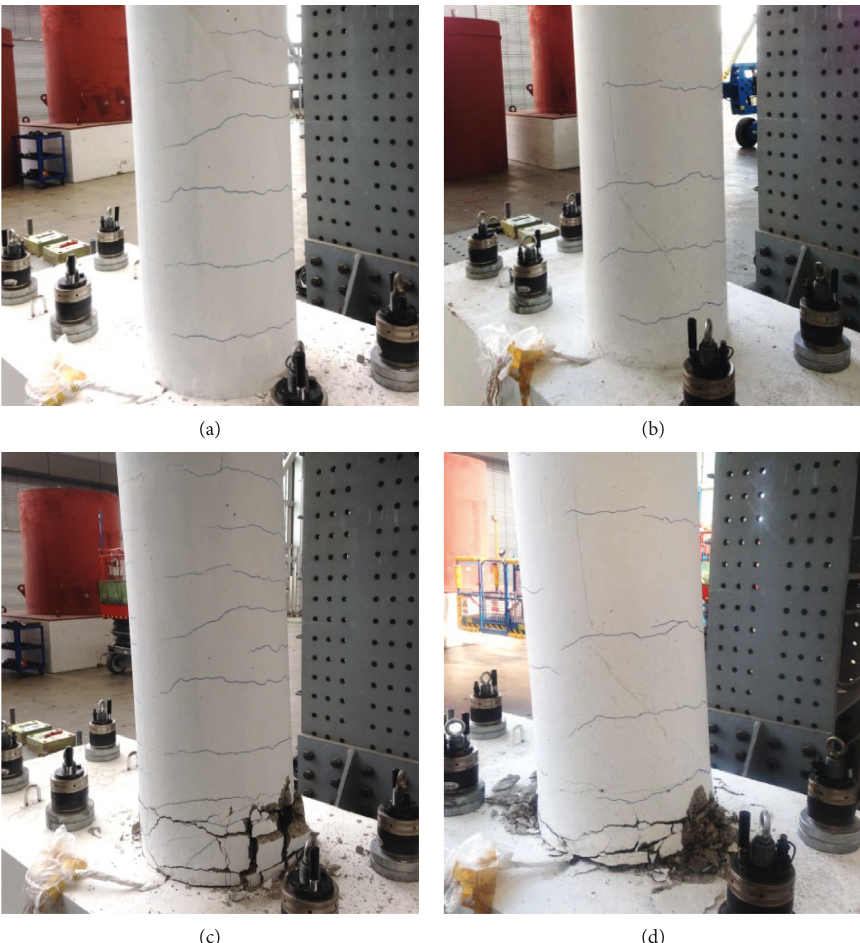
Figure 10: Connection damages: (a) T-SD400 at 0.67% drift; (b) T-HMSB at 0.67% drift; (c) T-SD400 at 5.48% drift (failure); and (d) T- HMSB at 10.09% drift (failure).